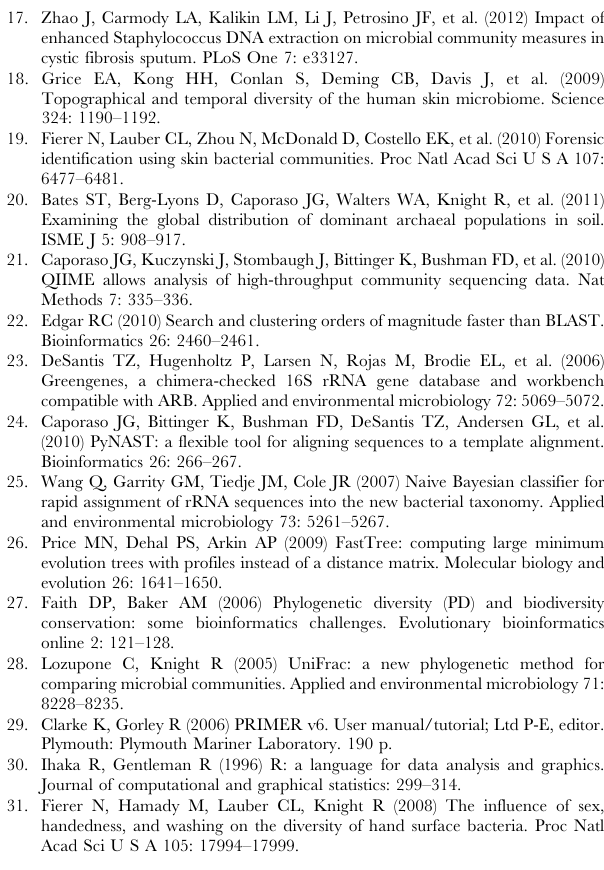
Figure S2 PCoA plots illustrating differences in com- munity composition across body habitats (a and c) and no differences based on which protocol was used across individuals (b and d). Plots a and b are based on unweighted UniFrac distances while c and d are based on Bray-Curtis dissimilarity values. Results of ANOSIM tests are presented in the bottom right of each plot. Figure S3 PCoA plots derived from Bray-Curtis dissim- ilarities comparing the communities observed using the direct PCR (black circles) and standard extraction/ purification (grey circles) protocols. Letters A-D denote individual participants. Results of the ANOSIM testing for statistical differences between methods across individuals are shown for each body habitat. Note that individual C was not included in the underarm analysis as sequences were not obtained for the direct PCR samples. Figure S4 Variation of Bray-Curtis dissimilarities of replicate samples using the direct PCR (dark grey) and